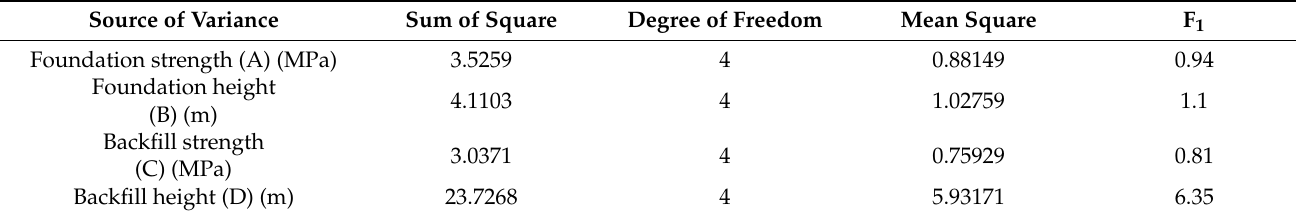
Table 5. The ANOVA of the safety factor of the roofs obtained by the numerical simulation.